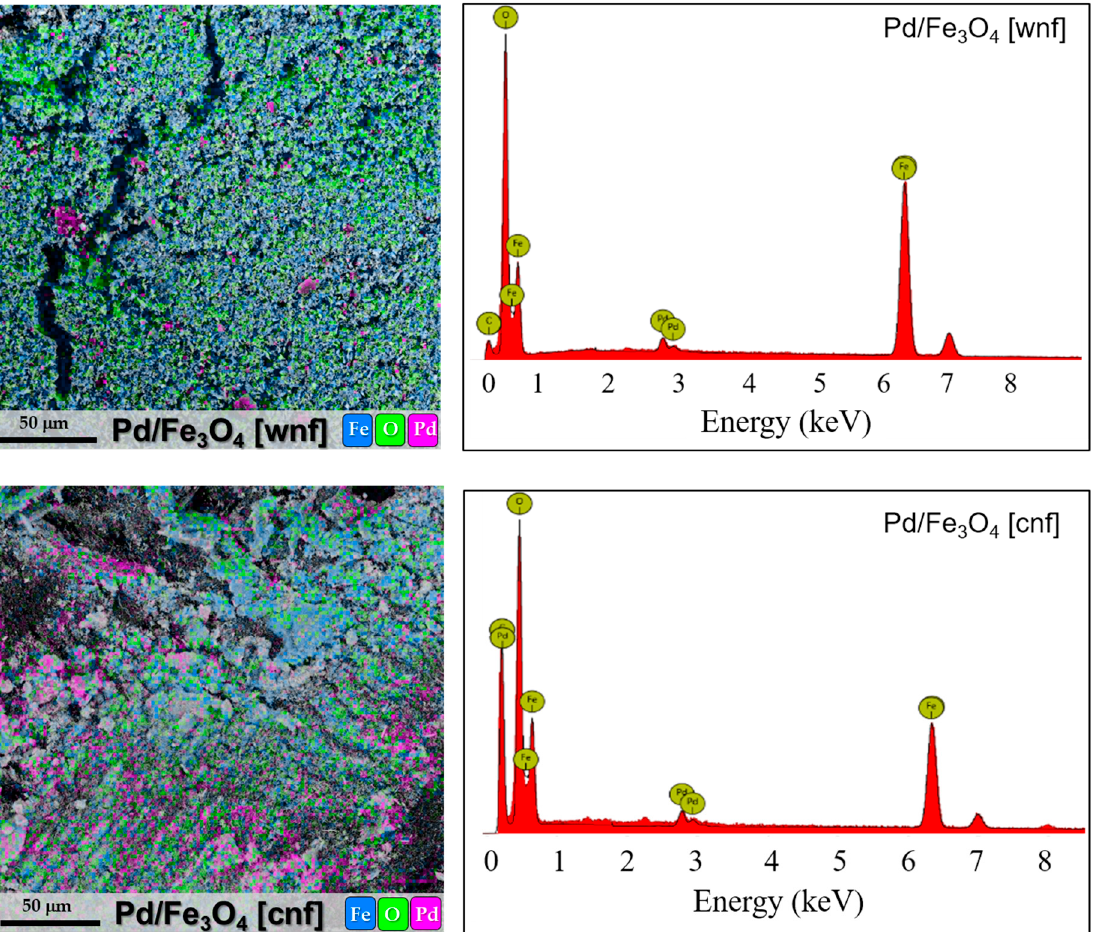
Figure 6. EDX spectra and colored maps of Pd / Fe 3 O 4 [wnf] and Pd / Fe 3 O 4 [cnf] samples.